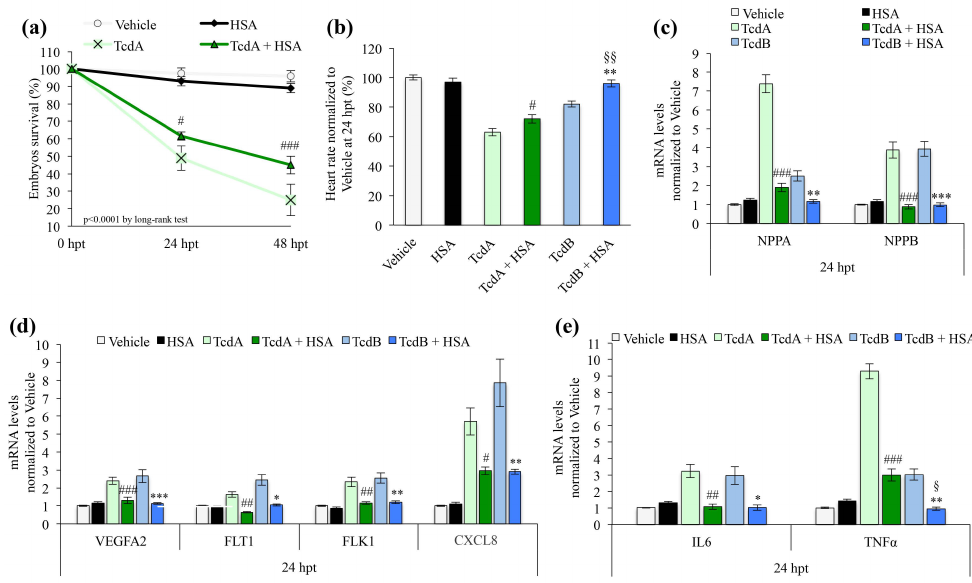
Figure8. Humanserumalbumin(HSA)protectszebrafishembryostowards C.di ffi cile toxinsintoxication. ( a ) Kaplan-Meier curve showing zebrafish embryo survival 24 and 48 h after treatment with vehicle, 50 ng HSA, 2.5 µ g / mL TcdA or TcdA + HSA. Data are presented as the mean ± SEM. ( n = 110 for each group) ( p < 0.0001 by log-rank test; # p < 0.05 TcdA compared to TcdA + HSA at 24 hpt; ### p < 0.001 TcdA compared to TcdA + HSA at 48 ht). ( b ) Evaluation of the zebrafish embryo heart rate